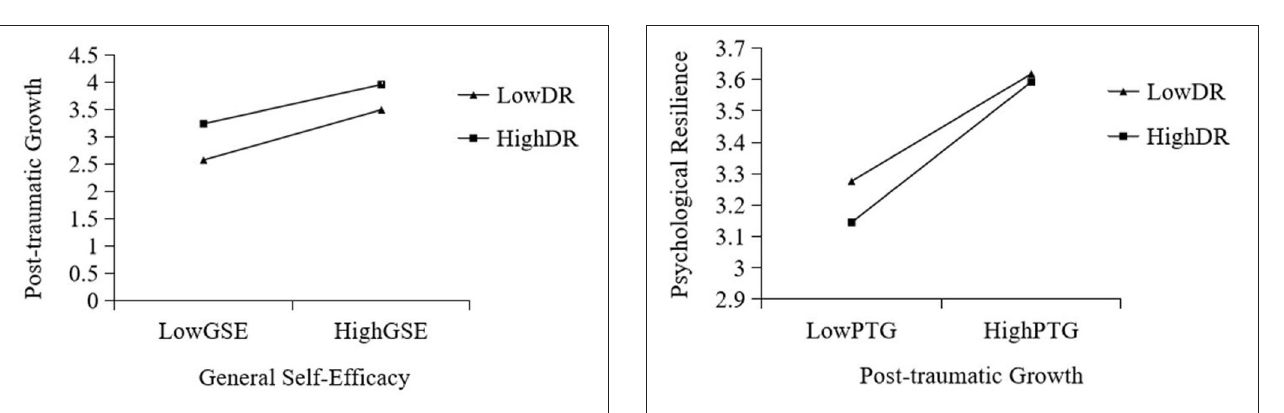
FIGURE 2 | Interactive effects of GSE and DR on PTG. DR, deliberate rumination; GSE, general self-efficacy.